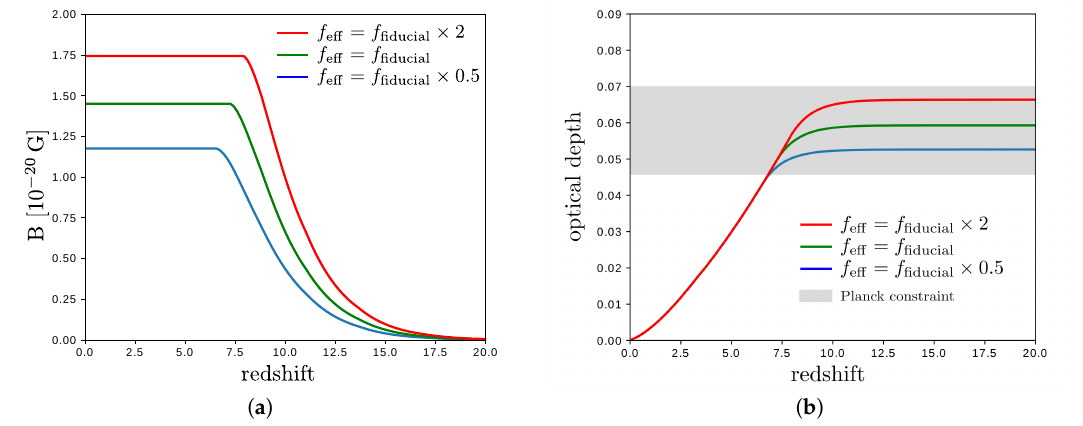
Figure 4. ( a ) Evolution with redshift of the mean comoving magnetic field strength accumulated in the IGM in different reionization histories. The green curve corresponds to the fiducial model assumed in [54] where f eff ≡ f ∗ f esc is an effective reionization efficiency. It combines the fraction f ∗ of baryons converted into stars in the halos hosting the ionizing sources and the fraction f esc of ionizing radiation that actually escapes into the IGM. The blue and red curves correspond, respectively, to reionization scenarios that are half and twice as efficient. All three considered reionization histories are in agreement with the Planck constraints ( τ = 0.058 ± 0.012, [70]), as illustrated in panel ( b ), which shows the cumulative Thomson optical depth τ to the